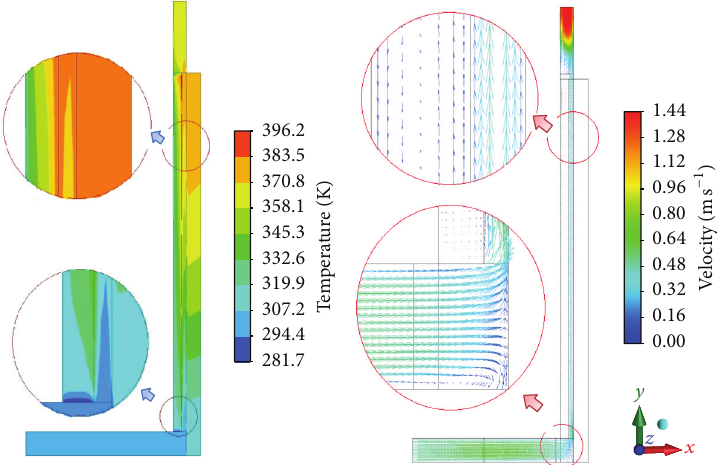
Figure 6: The flow field and temperature distribution in the computational domain.